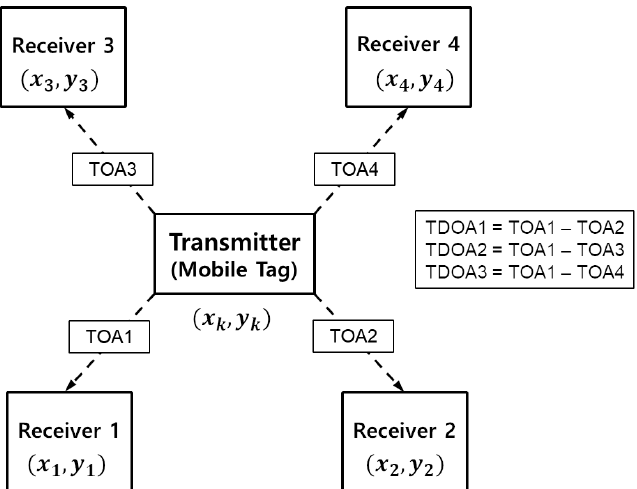
Figure 1. Schematic of indoor localization system using time difference of arrival (TDOA) measurements.